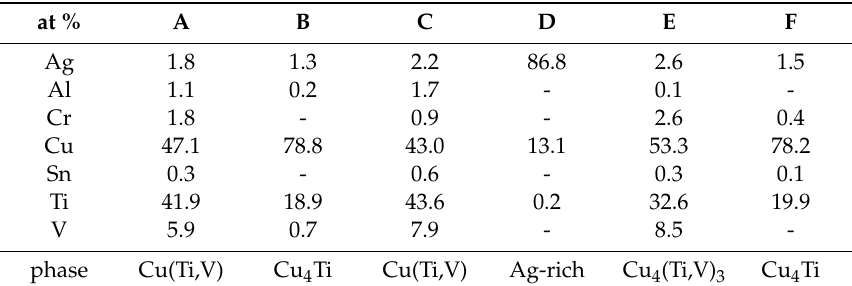
Table 2. Chemical analyses in Figure 4.